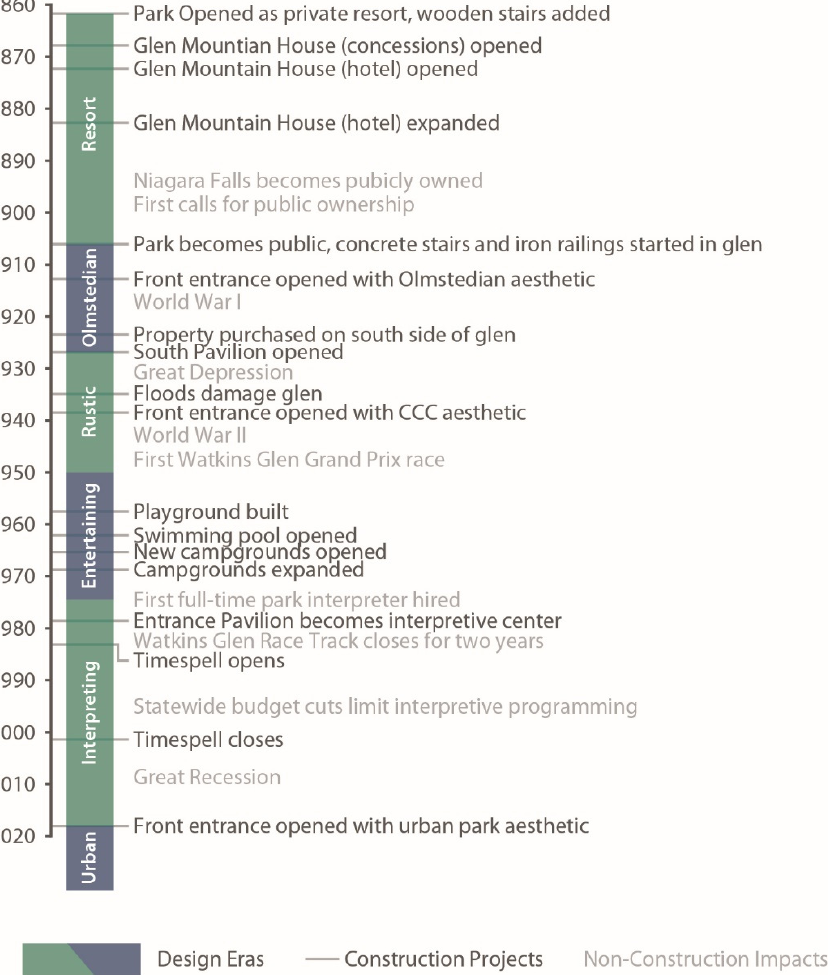
Figure 17. Summary of Design Changes at Watkins Glen, by author.